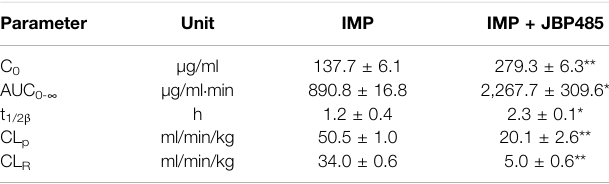
TABLE 2 | Pharmacokinetic parameters of IMP after intravenous administration of IMP (45 mg/kg) with or without JBP485 (90 mg/kg) in rats. Parameter